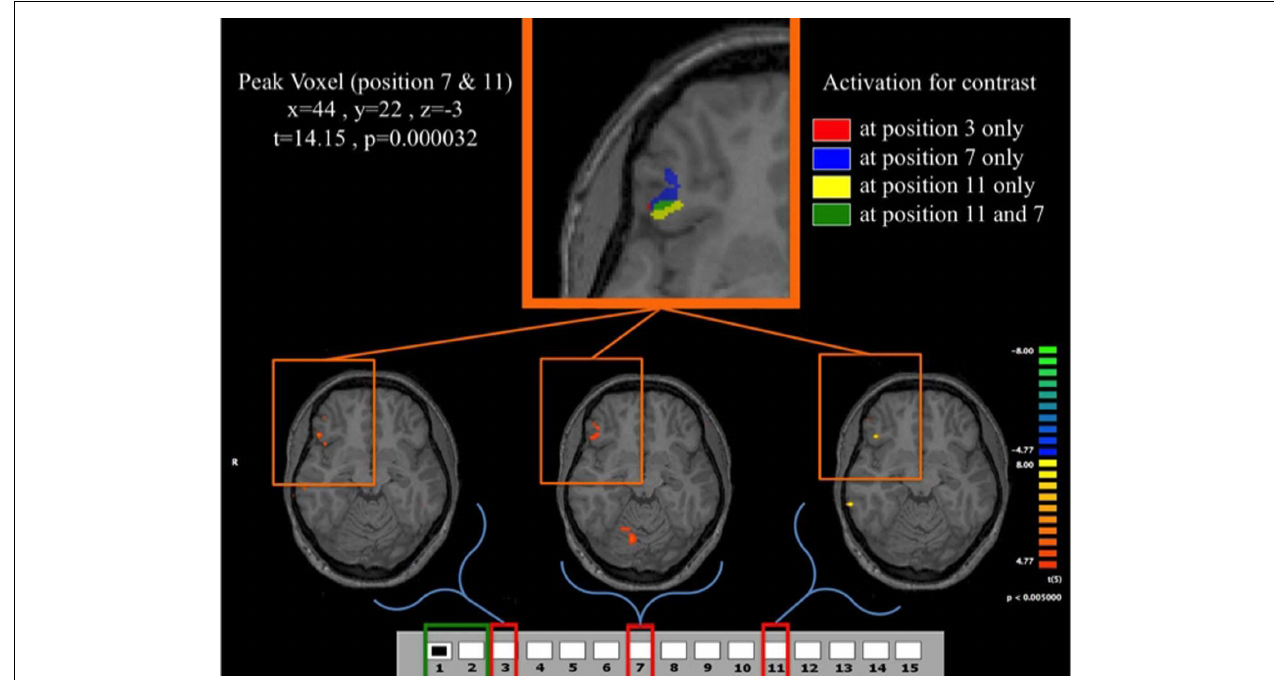
for 11-{1, 2}. As shown in Figure 5 , Fast Learners do not make mistakes past round 10, while Slow Learners commit mistakes even at position e11 past round 10. It should be also noted here that a direct test of the interaction between subjects’ categorization as Fast/Slow Learner and a dummy variable indicating Early/Late trials did not yield a statistically significant effect ( p = 0.158 two-sided, see Table 4 ).We believe that the failure to identify such an effect at conventional significance level in our data may be due to small sample size, and an insufficiently precise measure of when subjects learn the